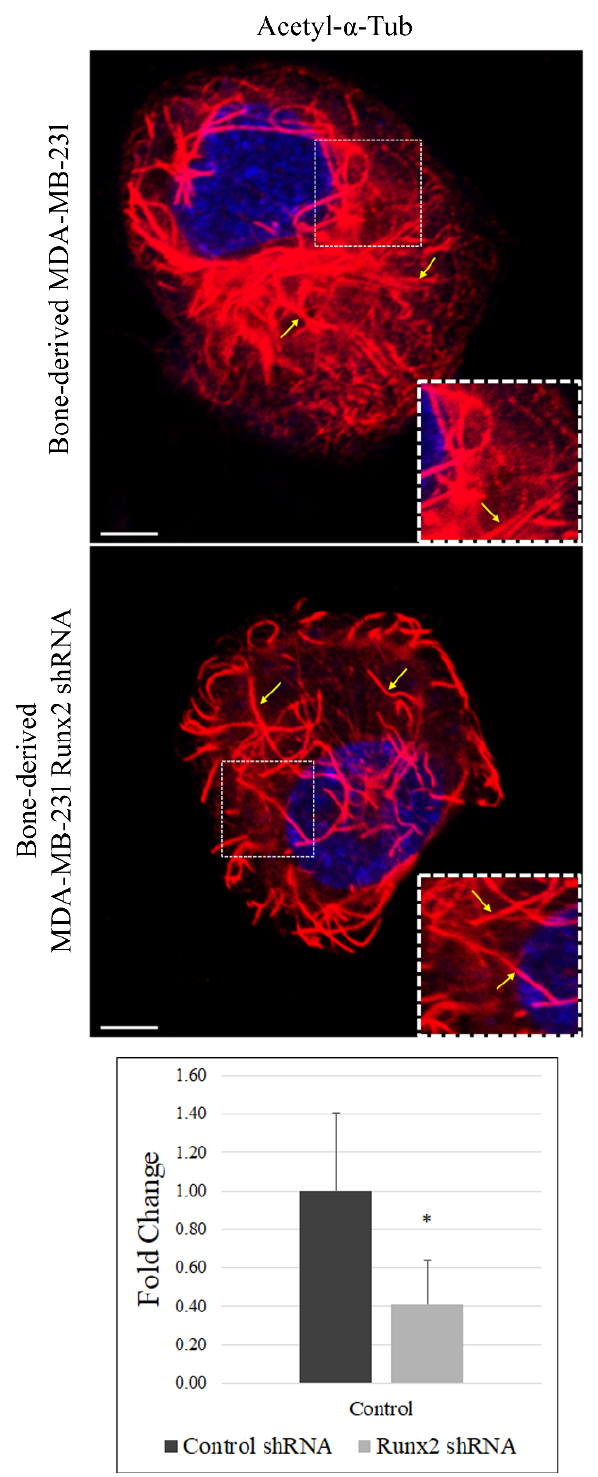
Figure 1. Loss of Runx2 reduces α -tubulin acetylation in bone-derived MDA-MB-231 cells. Im- munofluorescence studies show reduced acetylation in the absence of Runx2 in BoM-MDA-231. The fixed cells were analyzed for acetyl- α -tubulin (Lys40) (Alexa fluor-594/Red). Acetyl- α -tubulin (Lys40) is stained red, while nuclei are stained blue with DAPI. The yellow arrows show tubular structures. Cells ( n = 30) were quantified for tubulin signal intensity using ImageJ. Results were analyzed via an unpaired t -test (* p < 0.01). The scale bar represents 50 µ m. The images shown are representative of 3 independent experiments.